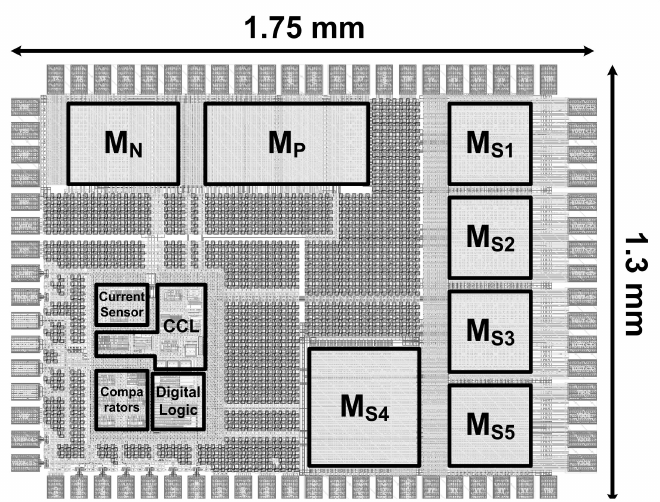
Figure 10. Layout of the proposed hybrid comparator-charge control SIMO DC-DC converter. The total area including the pad is 2.275 mm 2 (1.75 mm × 1.3 mm), of which the core